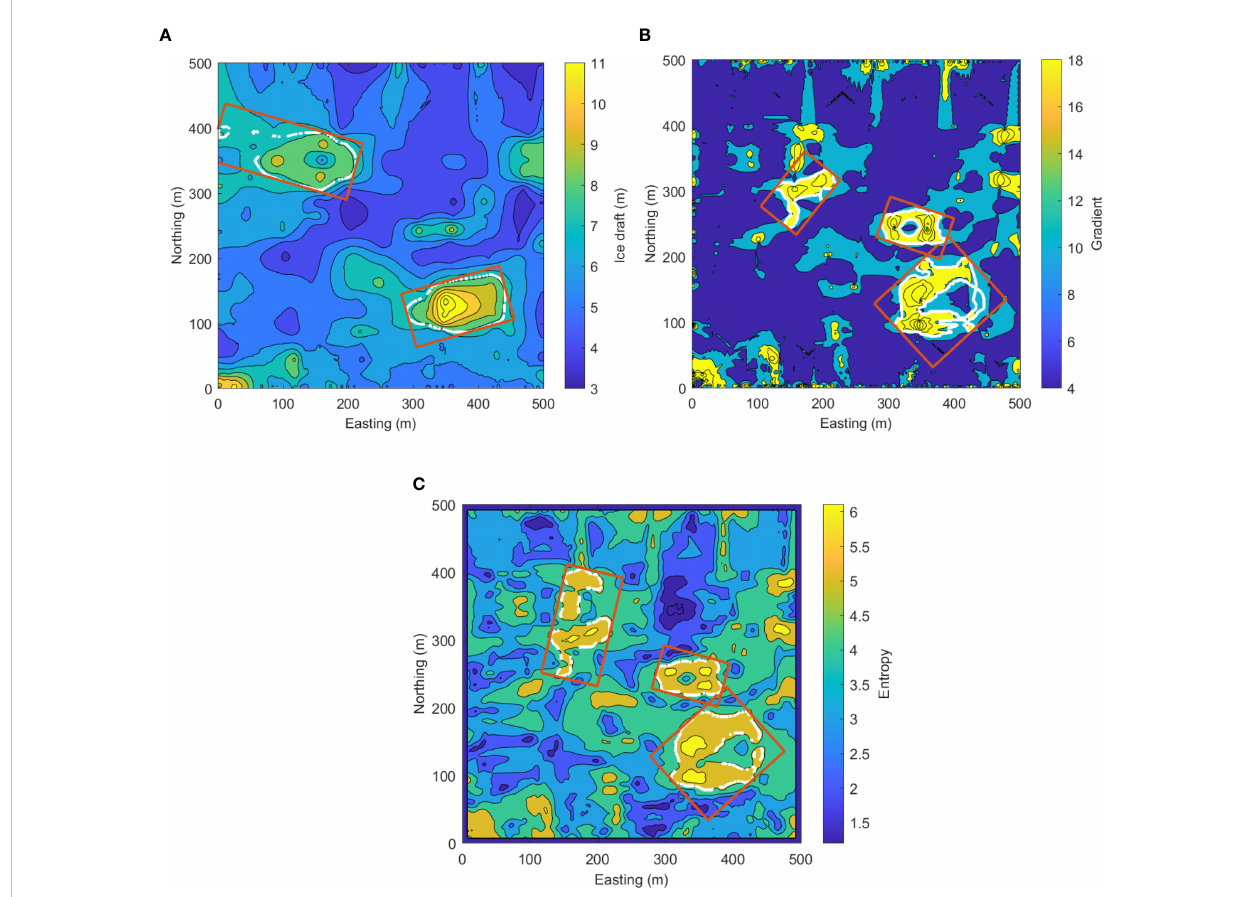
FIGURE 8 Extracted rectangles for intensive mapping by different criteria (White dash-dotted contours indicate the extracted regions of interest. Red rectangular boxes show the minimum area bounding rectangles of the interested regions). (A) Interested area extracted by ice draft criterion. (B) Interested area extracted by ice draft gradient criterion. (C) Interested area extracted by ice draft entropy